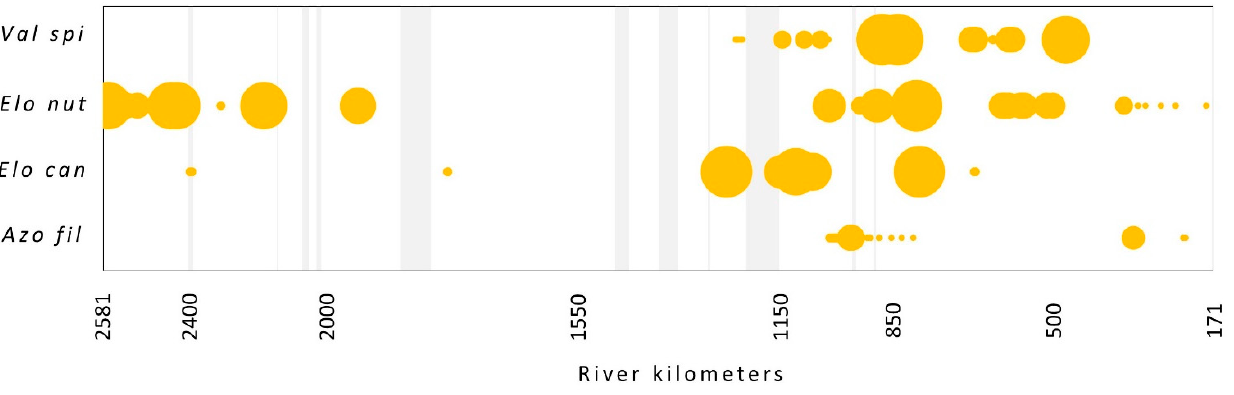
Figure 4. The occurrence of neophyte species (according to EU list) along the flow. The size of the circles shows the relative abundance of each species. Light gray vertical bars represent the sections with no data. Species abbreviations: Val spi— Vallisneria spiralis, Elo nut—Elodea nuttallii, Elo can—E. canadensis, Azo fil—Azolla filiculoides.